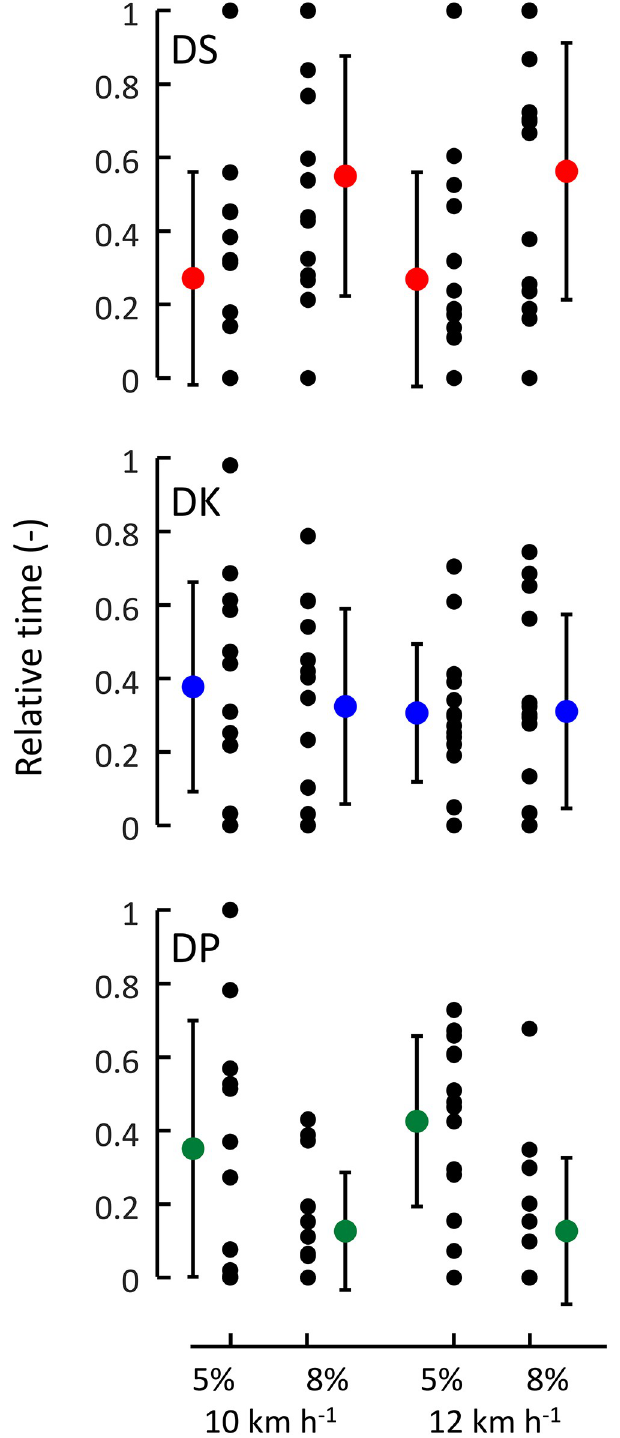
Fig 3. Mean, SD and individual values of relative time that the different techiques were applied during the four protocols (2 speeds x 2 inclines). Color signature for techniques is the same as in Fig 1. The individual values often range from 0 and